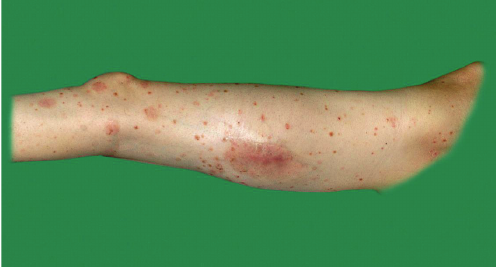
Figure 1: Preoperative clinical picture showing psoriasis vulgaris e ffl orescence’s on the left thigh.